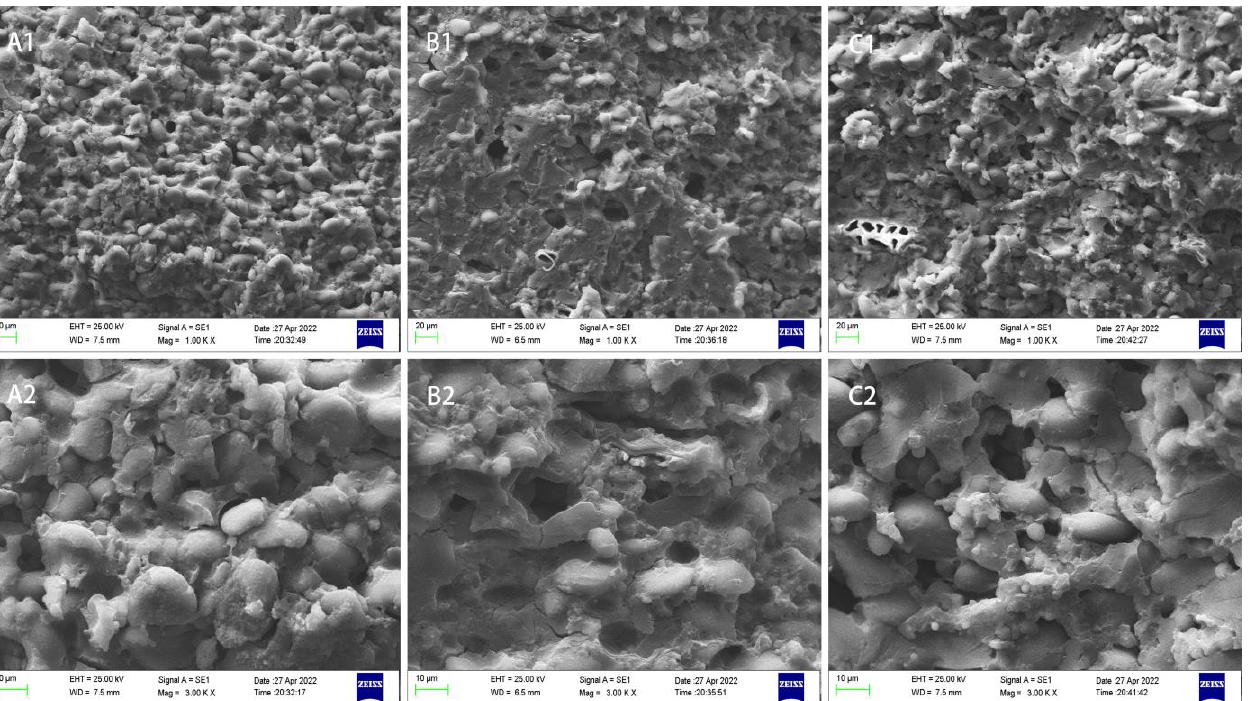
Figure 1. Inner microstructure of the raw noodles: ( A ) dried wheat noodle; ( B ) stone-milled dried whole wheat noodle; ( C ) commercially dried whole wheat noodle. Figures numbered 1 and 2 were taken at 1000× and 3000× magnification, respectively.